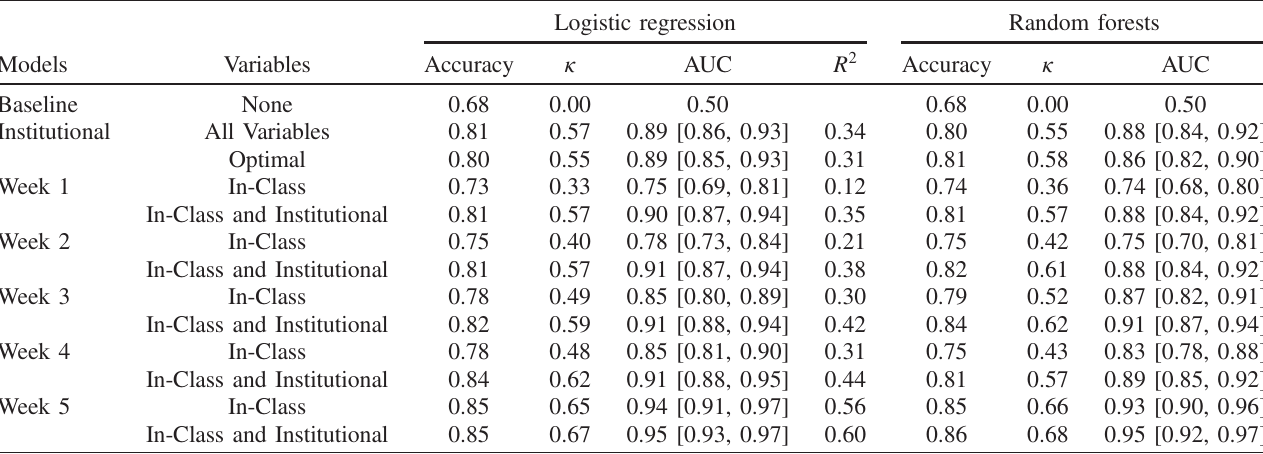
Logistic regression Random forests